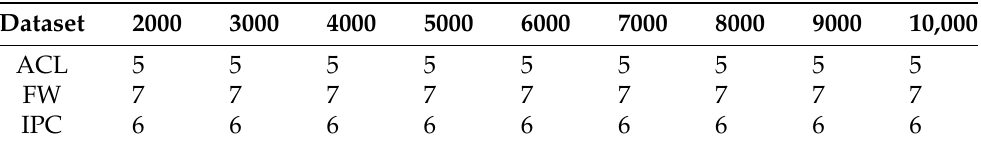
Table 2. Performance of different WC Form thresholds (AVE Form threshold: 2000, Form Switch threshold: 2000).